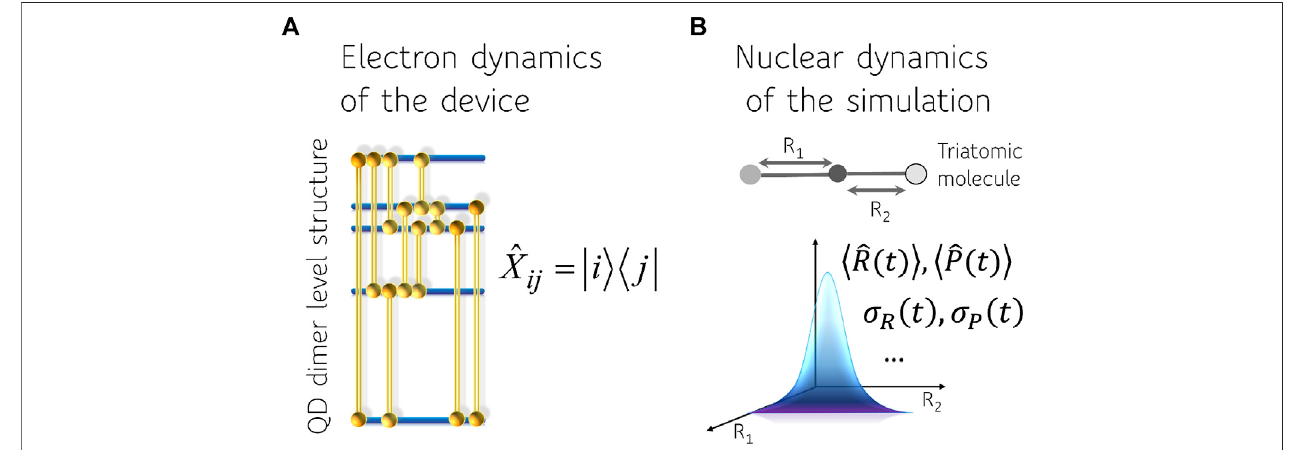
FIGURE 1 | Representation of the computing device (A) and the physical system (B) . The four bands of excited electronic states of the device that are used are indicated as well as the ten pairs i , j whose twenty corresponding coherences X ij are used as logic variables. The physical system we emulate is a vibrating triatomic molecule in a non-stationary quantum mechanical state. We will simulate the mean position and momentum of each of the two coupled oscillators as well as the respective widths, σ R and σ P